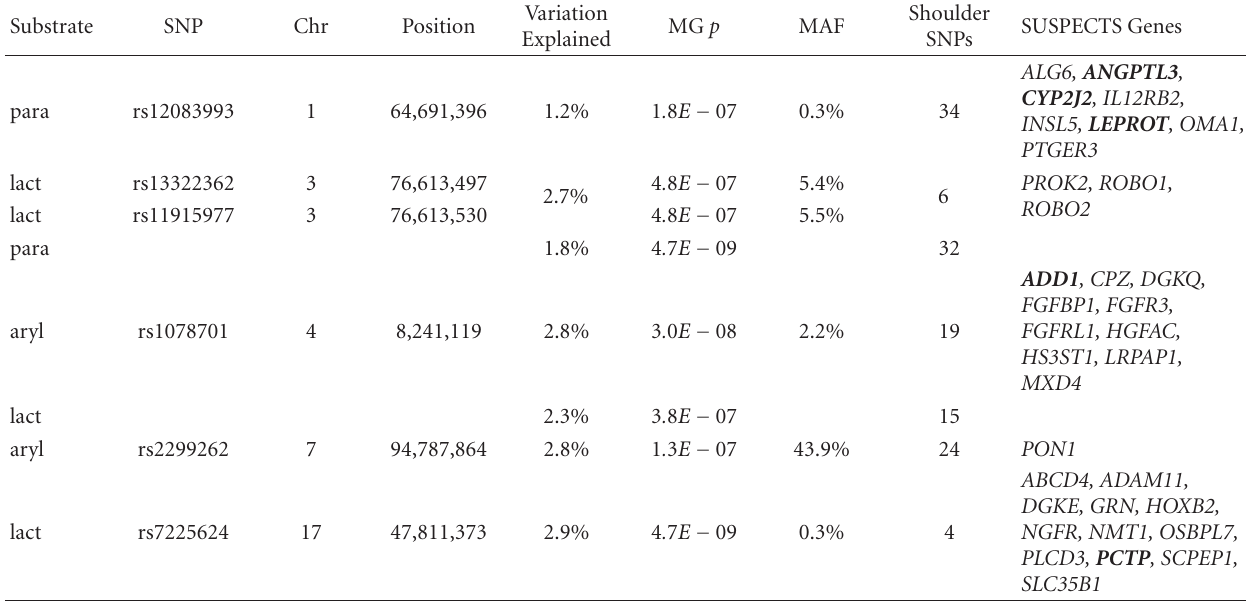
Table 2: Summary of Significant and Suggestive Associations. SNP associations varied among substrates with overlap only at rs1078701 on chromosome 4. For each SNP, the chromosomal location, proportion of variation in PON1 activity explained, measured genotype test P -value, and minor allele frequency are listed. Shoulder SNPs are SNPs ranking in the top 5% of associations located within 500 kb of the significantly associated SNP. Genes identified by SUSPECTS are within 7.5Mb of the candidate SNP and have a similarity score greater than 15. Bolded genes are discussed in the texts as the most likely contributors to PON1 activity based on known function, however, other genes may have unknown functions important in the regulation of PON1. The two associated SNPs on chromosome 3 are in perfect linkage disequilibrium and explain 2.7% of the variation in PON1-lact cumulatively. Variation Shoulder Substrate SNP Chr Position MG p MAF SUSPECTS Explained SNPs